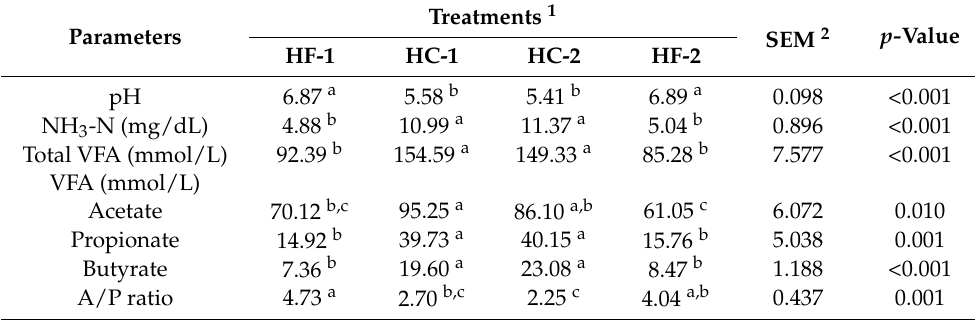
Table 2. Rumen fermentation profile of Holstein Friesian cows fed with different diet